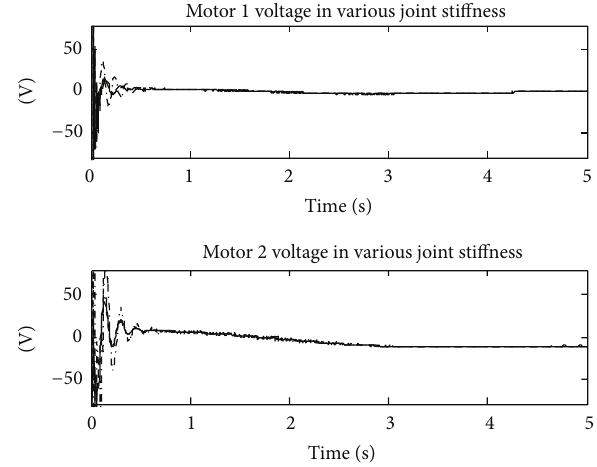
Figure 8: Motor voltage in various values of joint